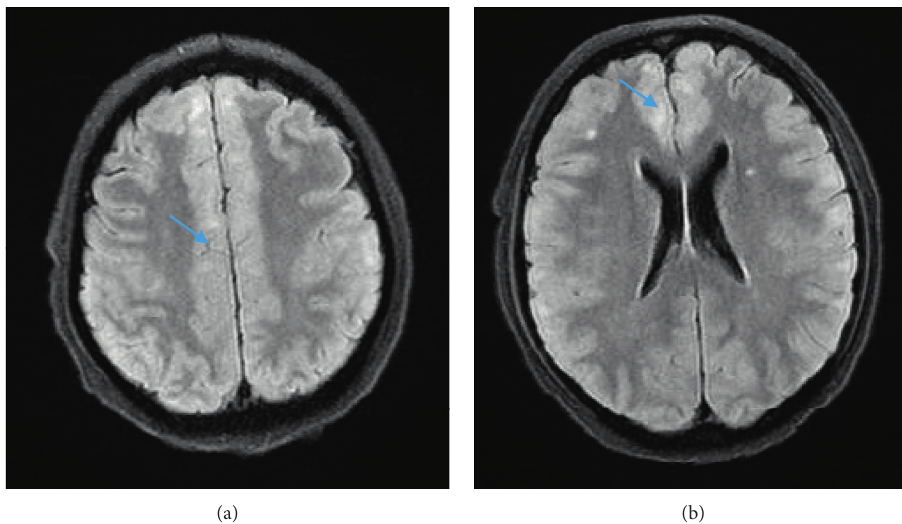
Figure 4: MRI brain with IV contrast showing several scattered bilateral foci of increased T2/FLAIR signal in the bifrontal regions. Also noted, as shown by the blue arrows, was a diffuse swelling of the gyri involving bilateral frontal and anterior parietal